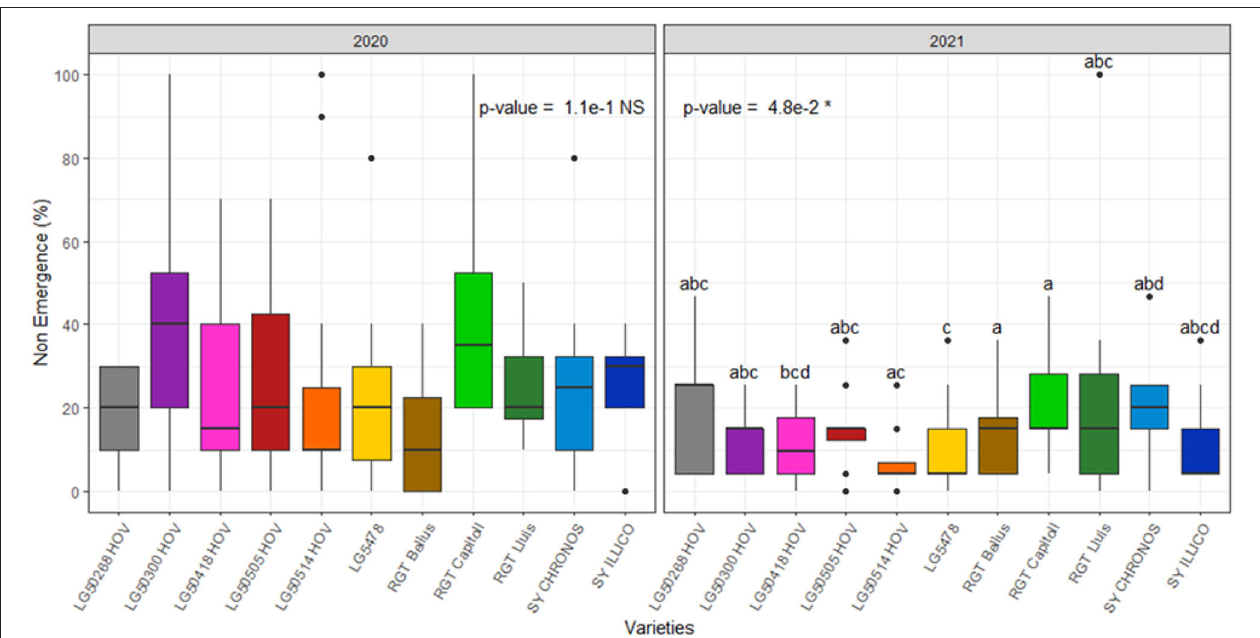
FIGURE 7 | Rates of non-emergence of 11 hybrid oilseed varieties of sunflower over the two experimental years, 2020 and 2021 at the Auzeville experimental station. Vertical bars reported in the figure represent confidence intervals. The different letters indicate a significant difference between the tested